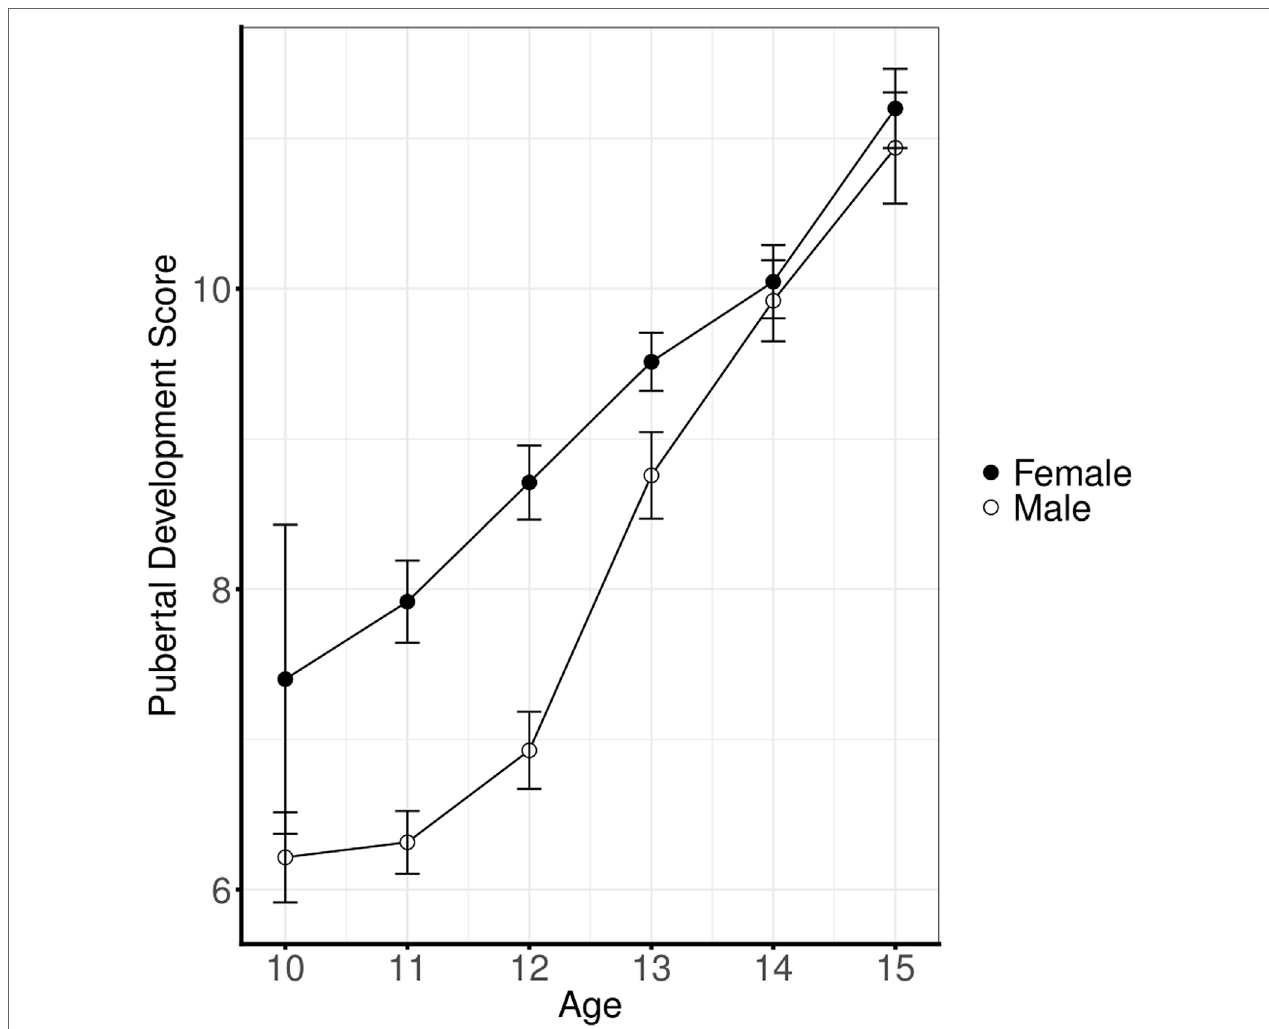
FigUre 1 | Mean pubertal development scores for female and male as a function of age. Vertical bars indicate the standard